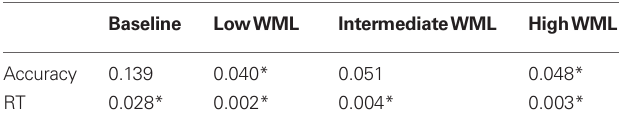
Table 4 | p values for TBI and Control groups comparisons on the behavioral